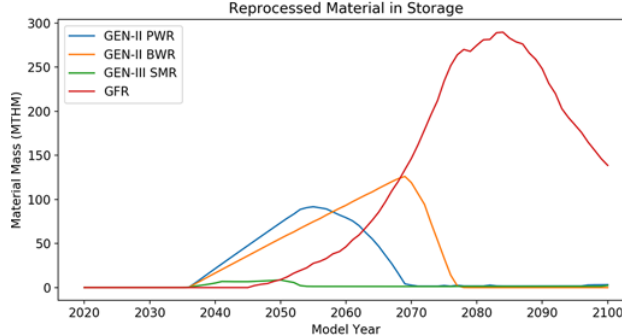
Fig. 3. Reprocessed material available for use in GFR fuel fabrication by reactor of material